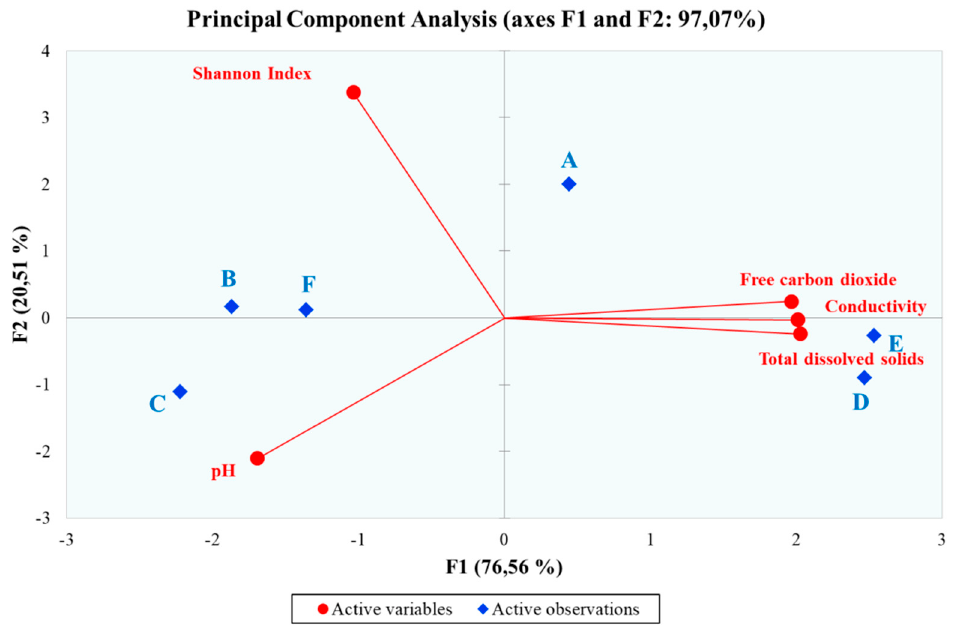
Figure 3. Principal components analysis (PCA) with the MiSeq Illumina fingerprints. F1 and F2 are shown on x and y axes, respectively. For a better comprehension of Figure 3, samples were colored in blue and parameters considered in the analysis in red. Whereas the samples are positioned in different or opposite quarters with respect to the parameters and are therefore far from the parameters lines, lower values of the considered parameters were registered. If samples registered higher values for specific parameters, they are positioned closer to the respective physical–chemical indi- cator.